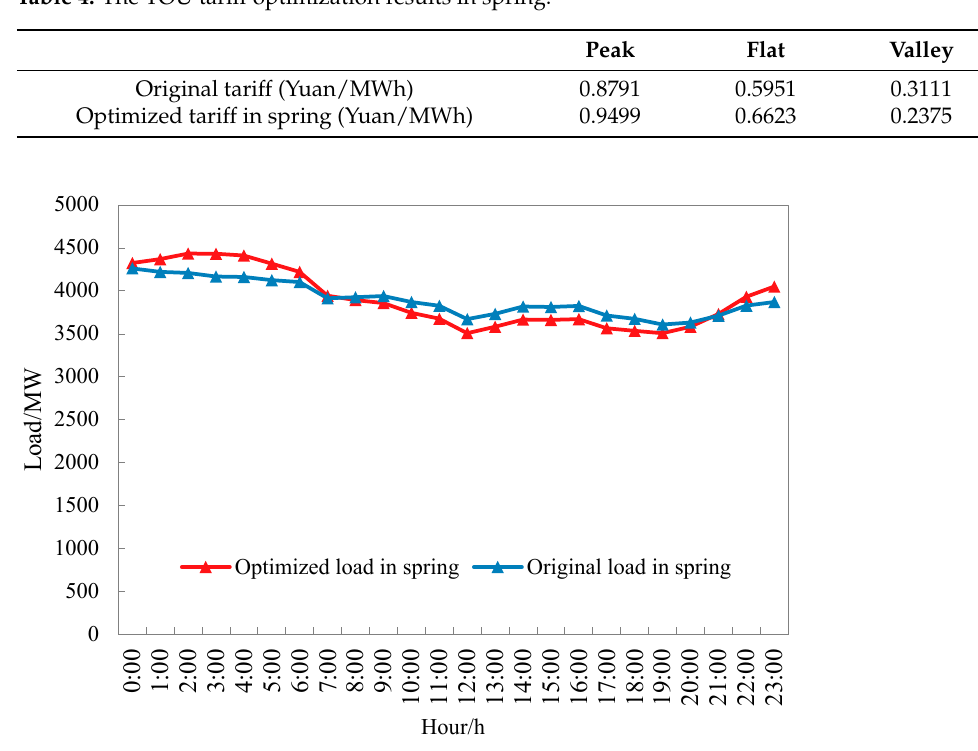
Figure 3. The load optimization results in spring.